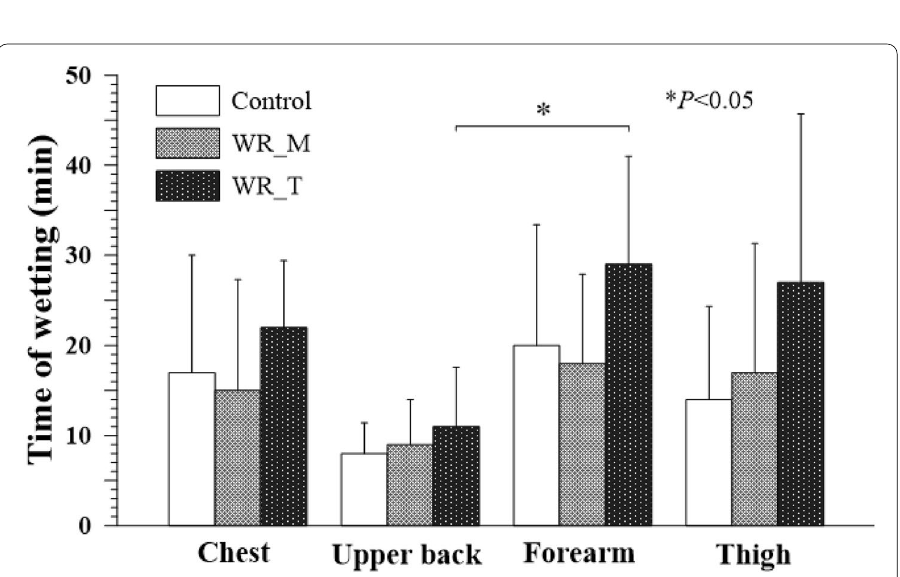
Fig. 4 Time of wetting on four body regions while walking at 150 mm h − 1